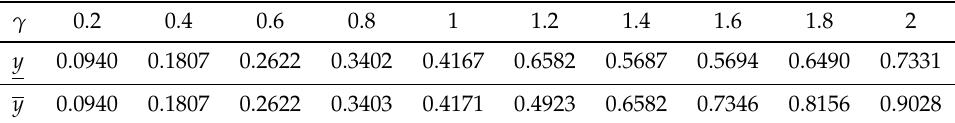
Table 4. Comparison of solutions for multiple t and γ = 1.